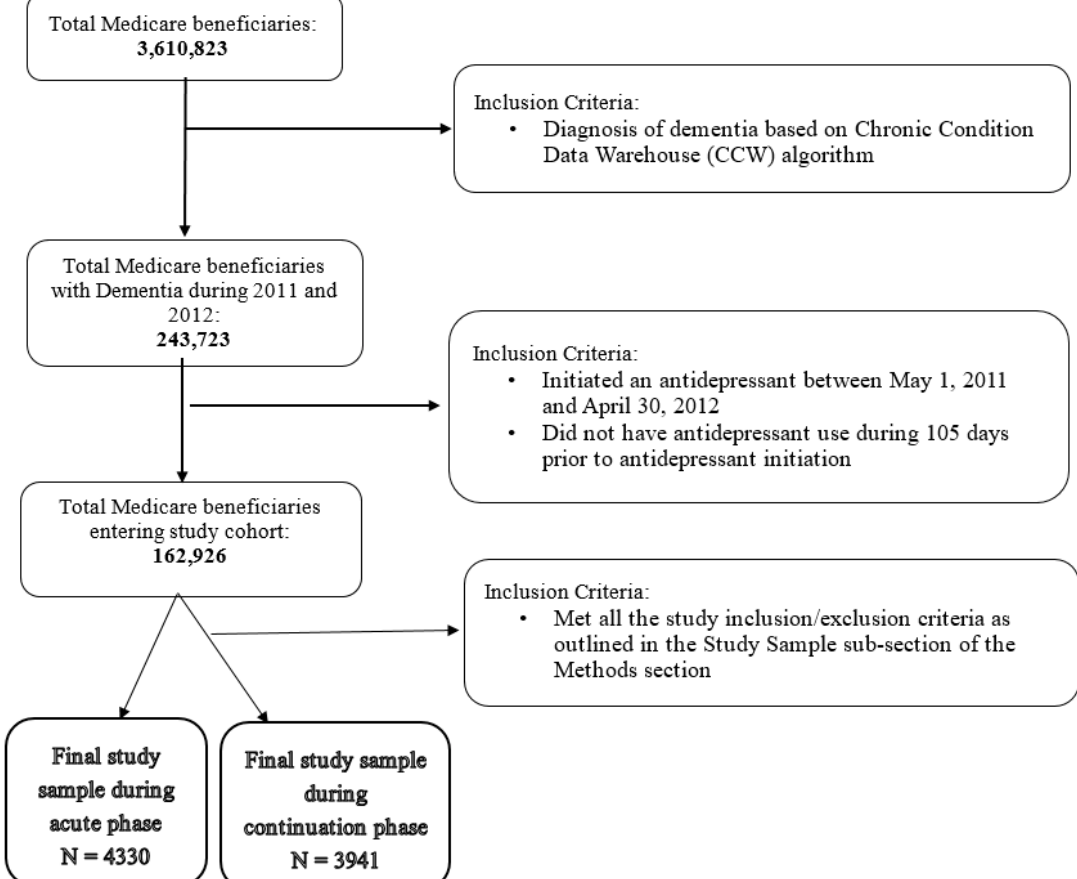
Figure 2. Cohort development for base case analysis.